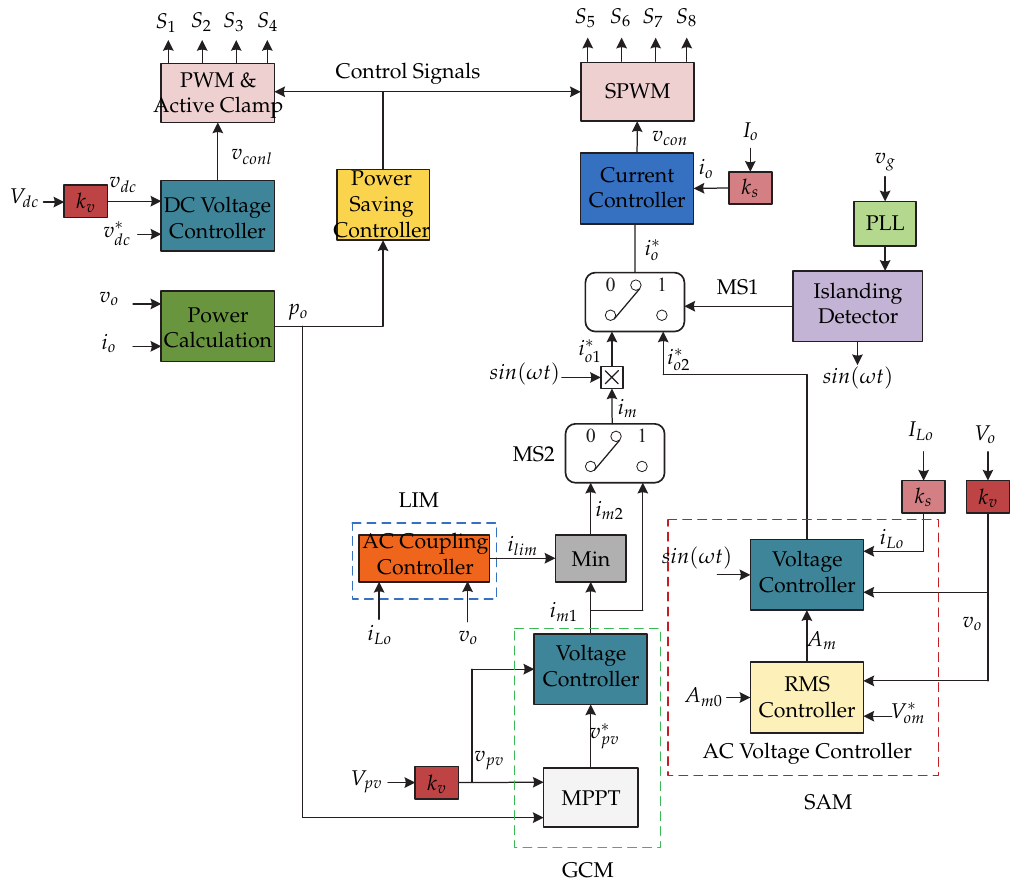
Figure 36. Control strategy proposed in [73].